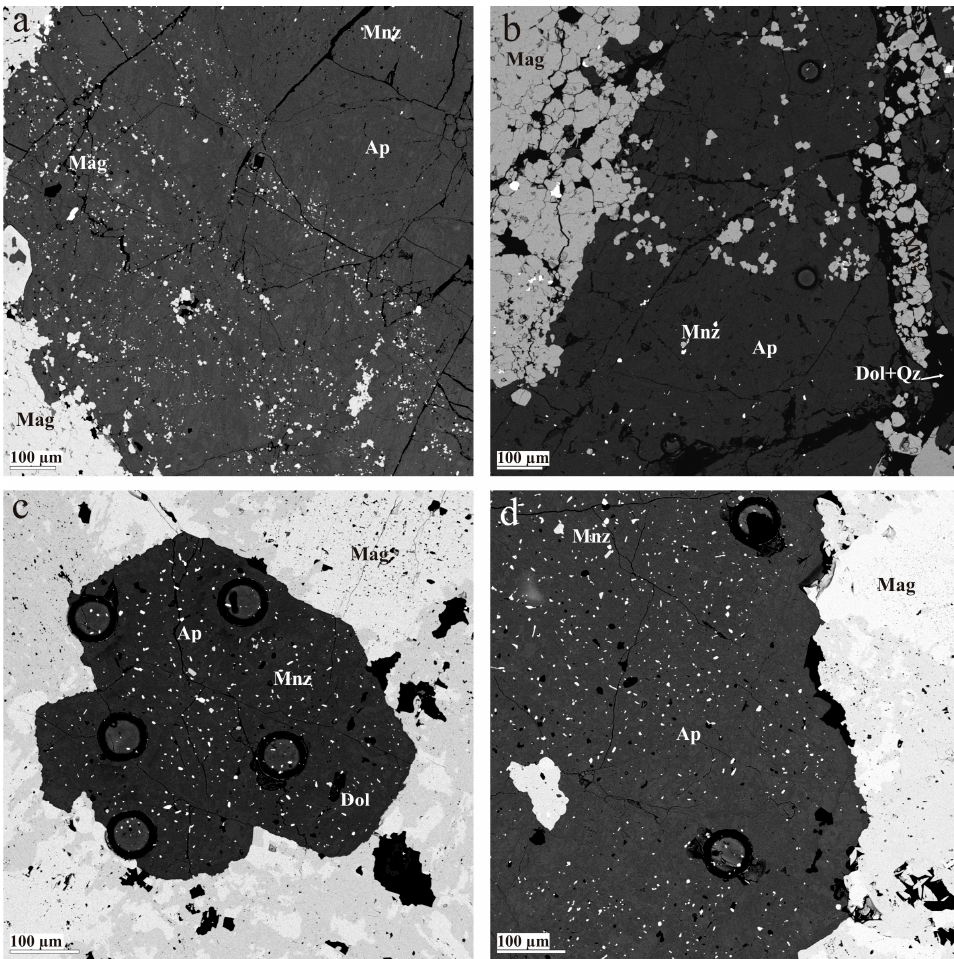
Figure 7. SEM-BSE images of apatite from MAV-inner type in the Chadormalu iron ores. ( a ) Banded structure with magnetite-rich bands in the marginal part of a coarse apatite crystal showing bright and dark areas; ( b ) Euhedral magnetite crystals in the host apatite; ( c ) Euhedral apatite crystals with abundant fine to coarser monazite inclusions; ( d ) Apatite (medium gray) with abundant fine monazite (bright) inclusions associated with magnetite (light grey). Abbreviations: Ap = apatite; Mag = magnetite; Mnz = monazite; Dol = dolomite; Qz = quartz.